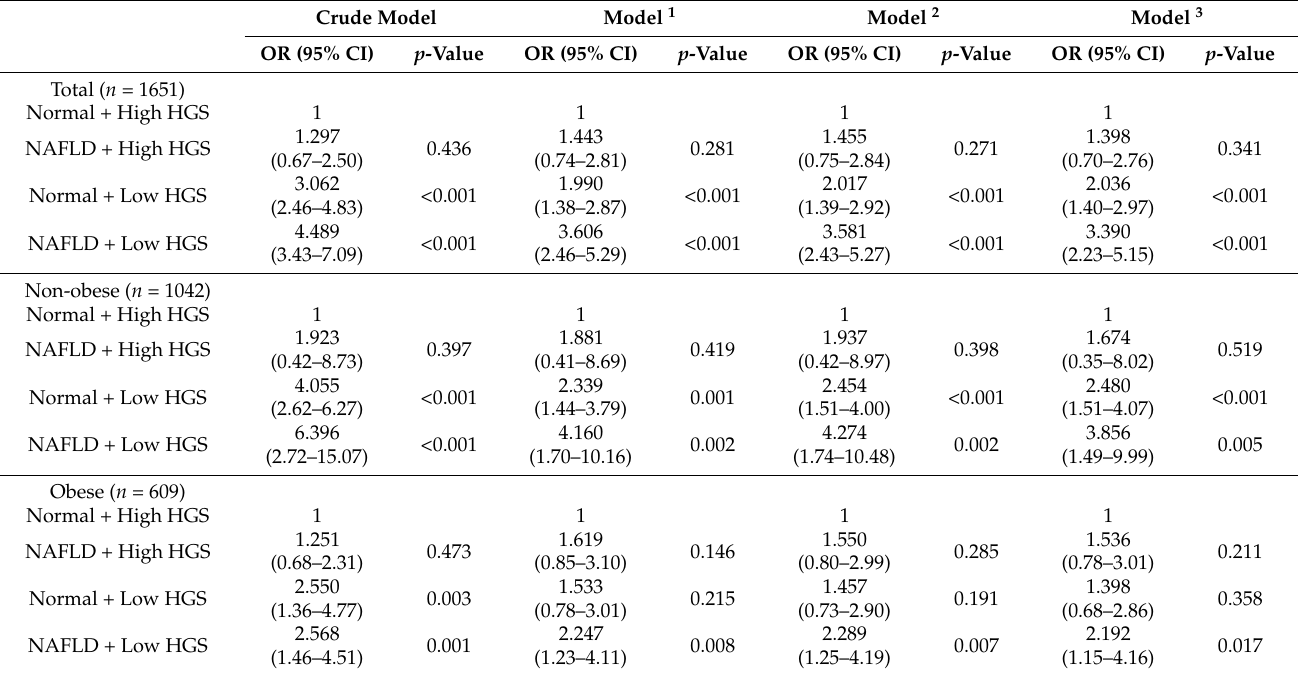
Table 4. The risk of reduced FVC according to NAFLD and relative hand grip strength-based subgroups. Crude